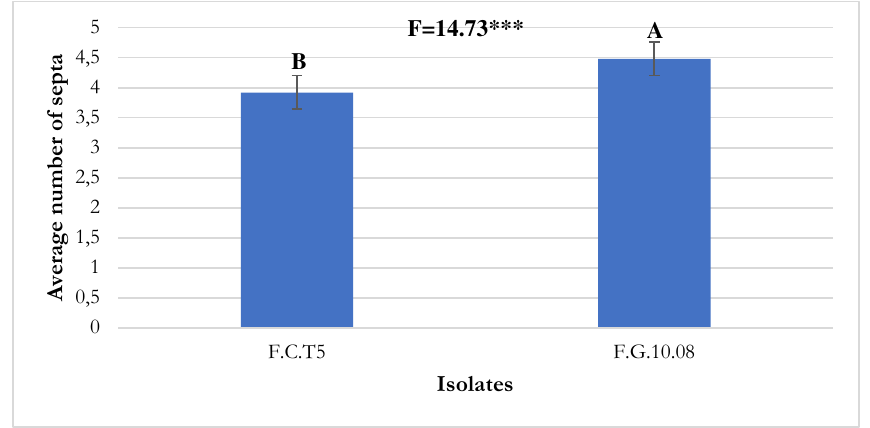
FigureFigureFigureFigure 9. 9. 9. 9. Mean number of septa of the two isolates